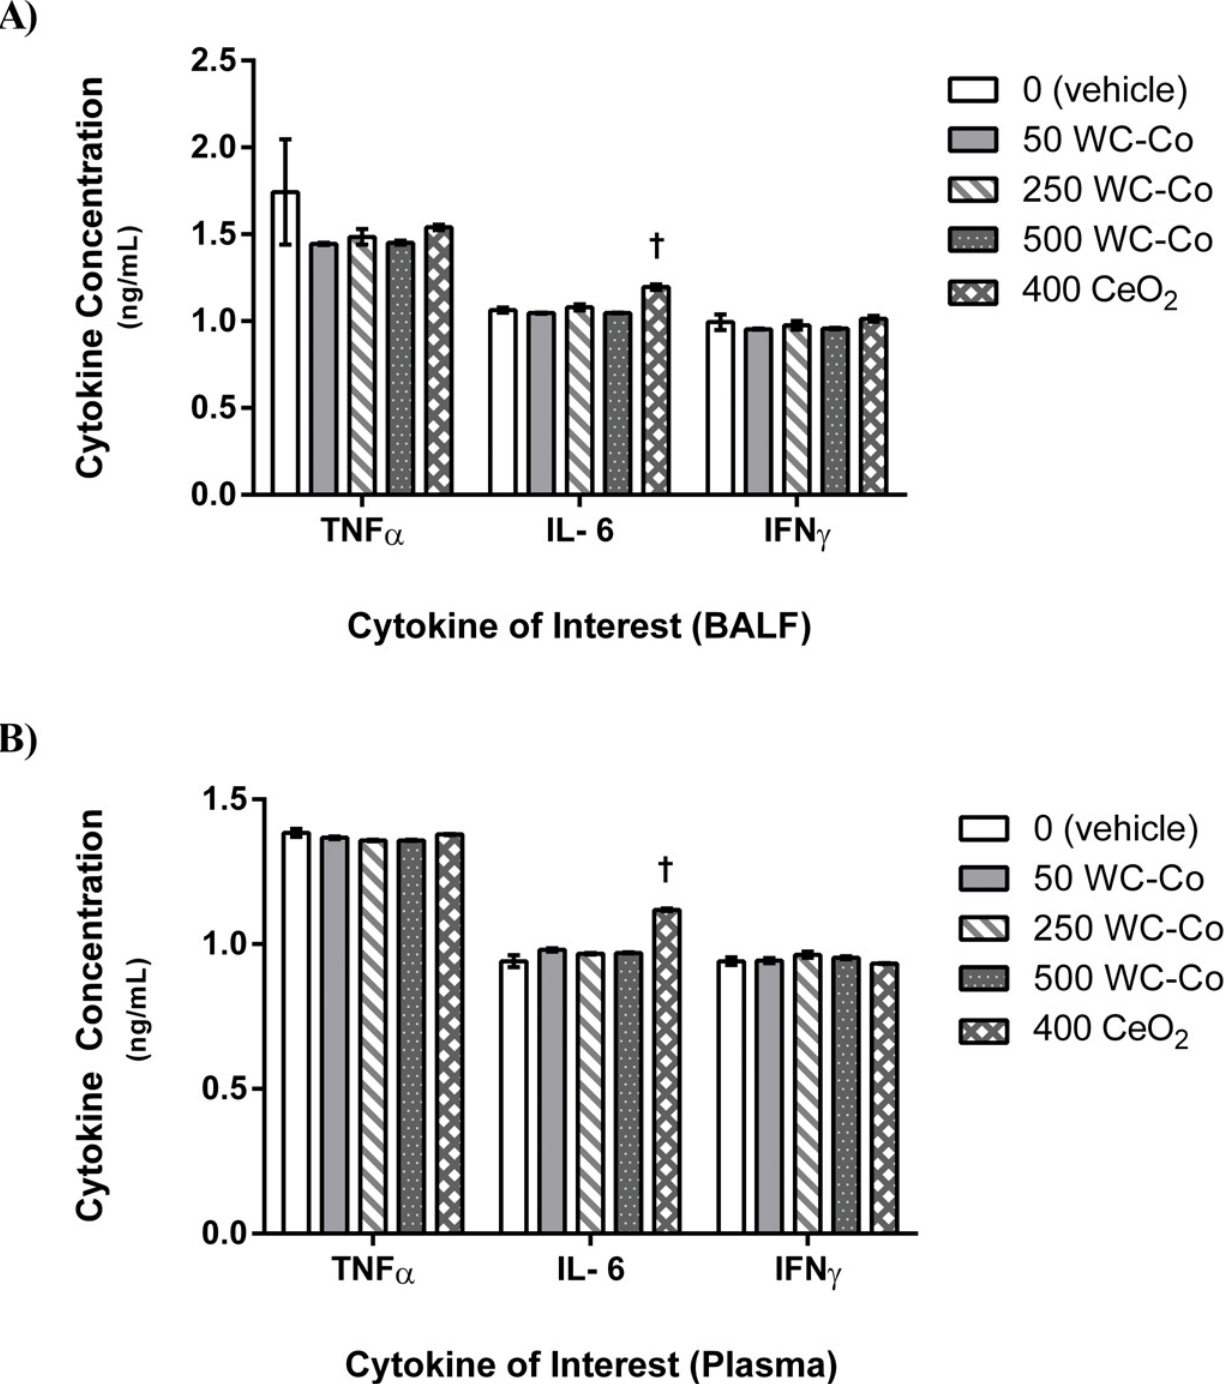
Fig 4. Inflammatory cytokine concentrations in A) BAL fluid and B) blood plasma. ( † P < 0.05 compared to the vehicle control and WC-Co NP exposed groups)